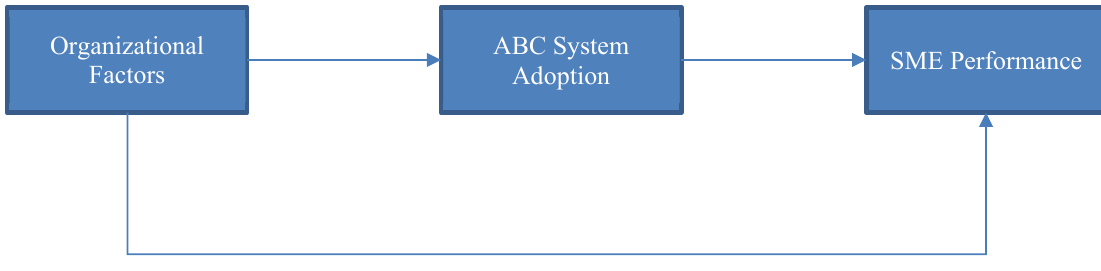
Fig. 1. Theoretical